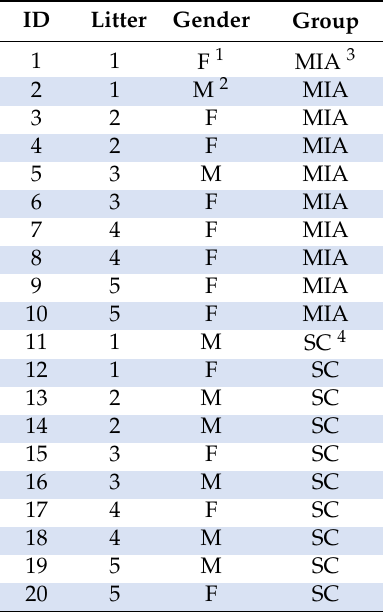
Table 1. Litter of origin, gender and treatment group of selected piglets. ID